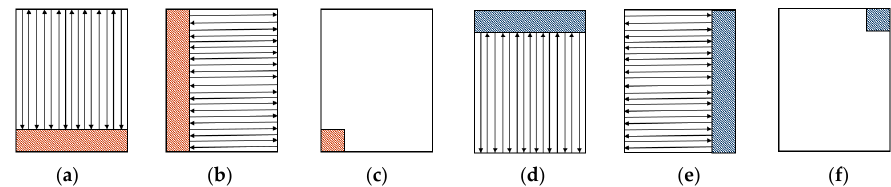
Figure 3. Scanning paths of the LMD nozzle. ( a ) Scanning path of the first layer; ( b ) scanning path of the second layer; ( c ) after scanning the first and the second layers, the part indicated by the square at the lower left corner is not scanned by the IMP; ( d ) scanning path of the third layer; ( e ) scanning path of the forth layer; ( f ) after scanning the third and the fourth layers, the part indicated by the square at the upper left corner is not scanned by the IMP.